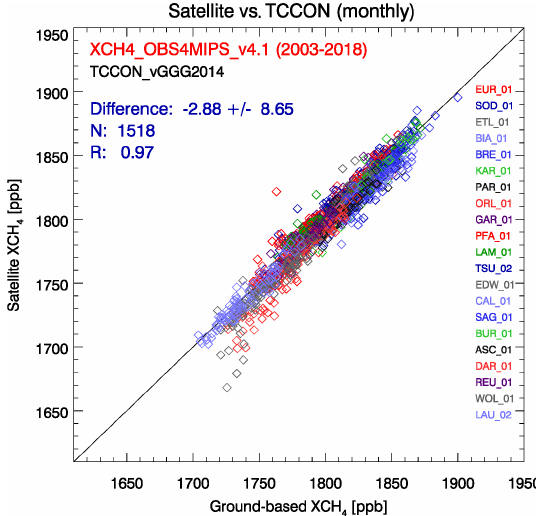
Figure 17. Summary of the comparison of product XCH4_OBS4MIPS with TCCON monthly mean XCH 4 . The comparison is based on 1518 monthly values. The mean difference (satellite – TCCON) is − 2 . 88ppb and the standard deviation of the difference is 8.65ppb. The linear correlation coefficient R is